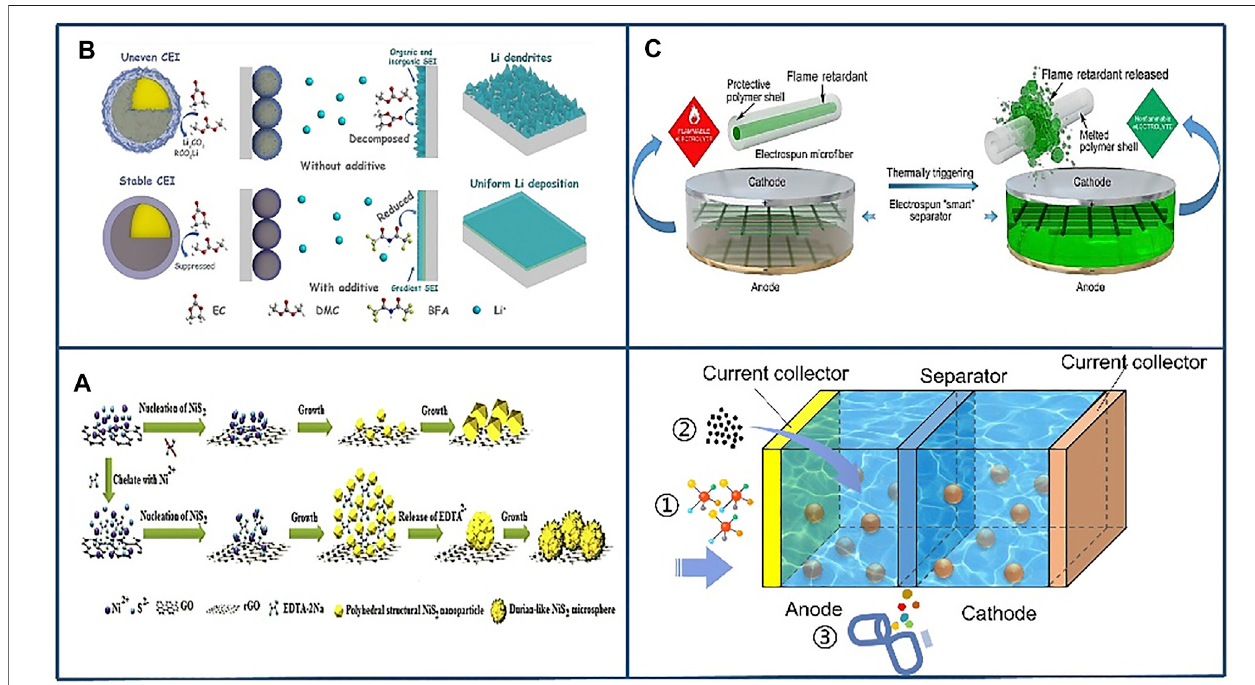
FIGURE 8 | Application of thermal barrier material additives in battery thermal runaway. Reproduced with permission (Yang et al., 2019). Copyright 2019, Elsevier. (A) NiS2@rGO electrode additives. Reproduced with permission(Mishra et al., 2018). Copyright 2018, KeAi. (B) Bis fl uoroacetamide (BFA) electrolyte additives. Reproduced with permission (Li et al., 2021). Copyright 2020, GDCh. (C) Thermoresponsive Polymer switch materials. Reproduced with permission (Liu et al., 2017b). Copyright 2017, Europe PMC.